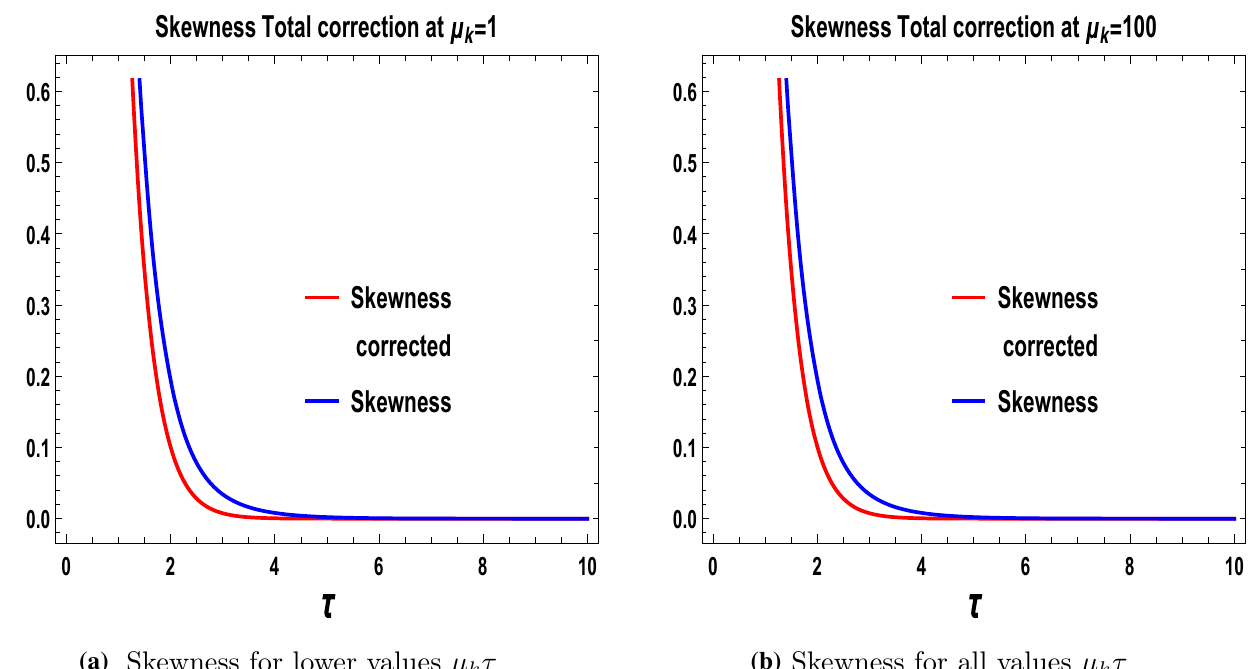
Fig. 53 Time dependent behaviour of Skewness without correction and with correction at different fixed range of μ k tribution and the predicted distribution function appears to be leptokurtic and has a broad right trailing end. All of this portion have a similar connection with Ref.